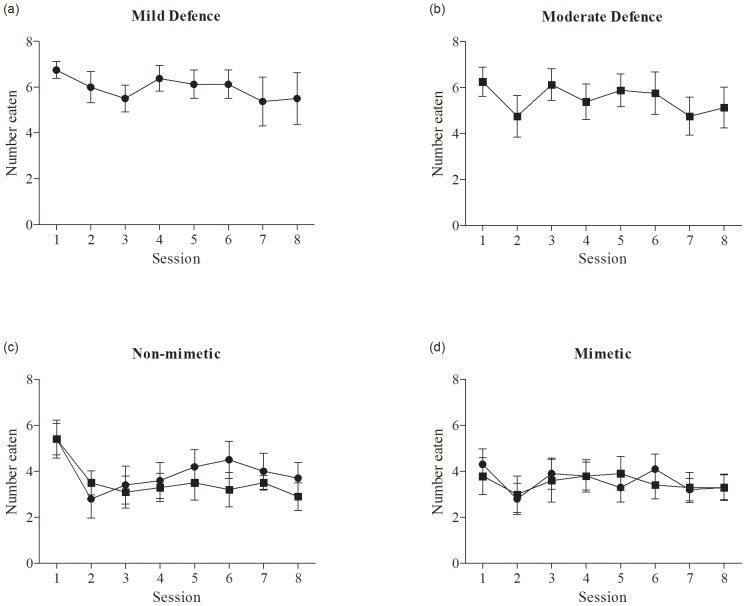
The mean numbers (+/− SE) of mildly defended (circles) and moderately defended prey (squares) eaten in each session by birds in each of the experimental groups (N = 10 for all groups).